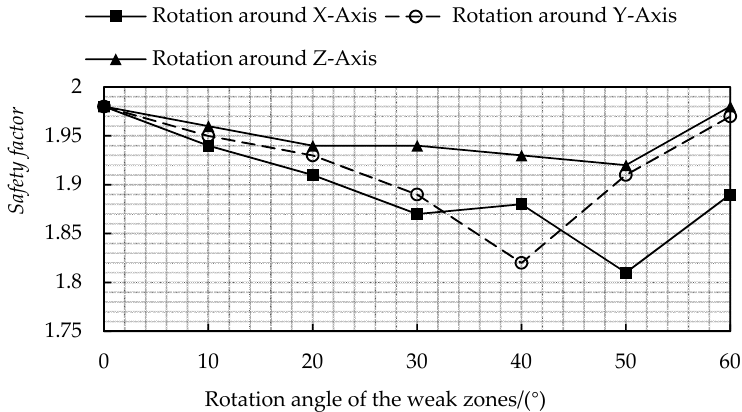
Figure 13. FOS under different rotational angles of the weak zones.